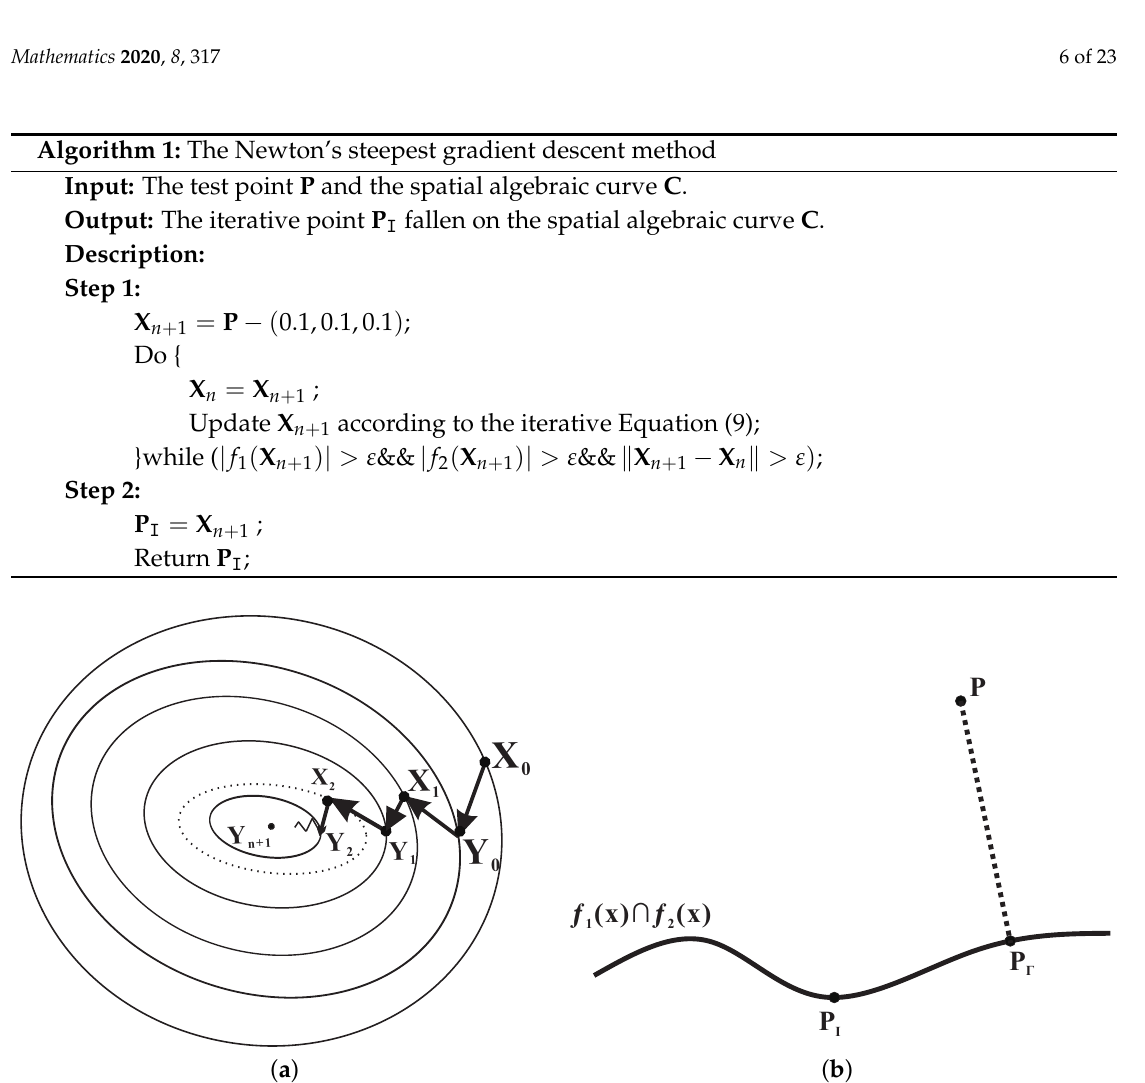
Figure 2. The entire graphic demonstration of Algorithm 1. ( a ) The whole iterative process of the Newton’s steepest gradient descent method; ( b ) The last step of the iterative point P I fallen on the spatial algebraic curve C via the Newton’s steepest gradient descent